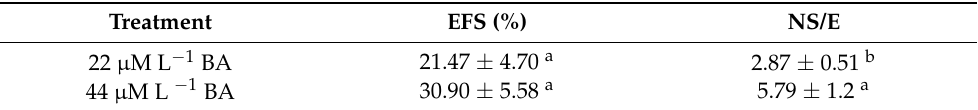
Table 3. Values for EFS (%) (explants forming shoots) and NS/E (number of shoots formed per explant) for Pinus halepensis apical shoot buds induced under two different concentrations of BA (22 and 44 µ